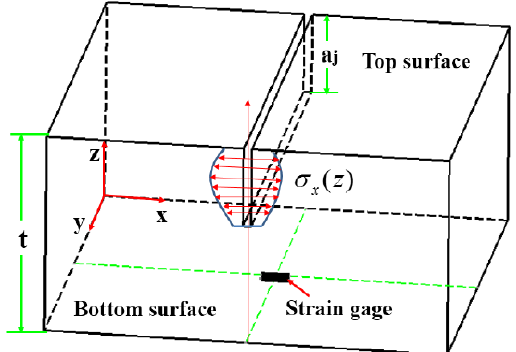
Figure 2. Measurement of strains by crack compliance method.